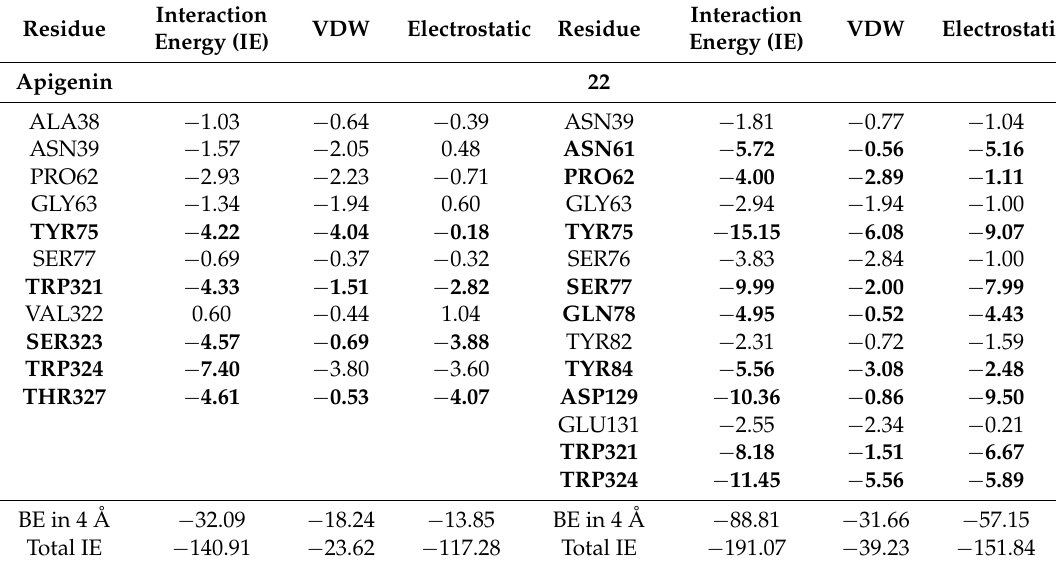
Figure 5. Superimposed the complex structures of apigenin and 22 with human hyaluronidase ( left ). The interactions with residues interaction energy below ´ 4 kcal/mol of apigenin ( right , top ) and 22 ( right , bottom ) with human hyaluronidase were illustrated. The π – π and hydrogen bonding interaction are depicted in orange and green dashed, respectively. Table 5. Contribution of the interaction energy in kcal/mol of human hyaluronidase binding residues in the 4 Å from apigenin and 22 . Residues with strong interaction energy below ´ 4 kcal/mol are